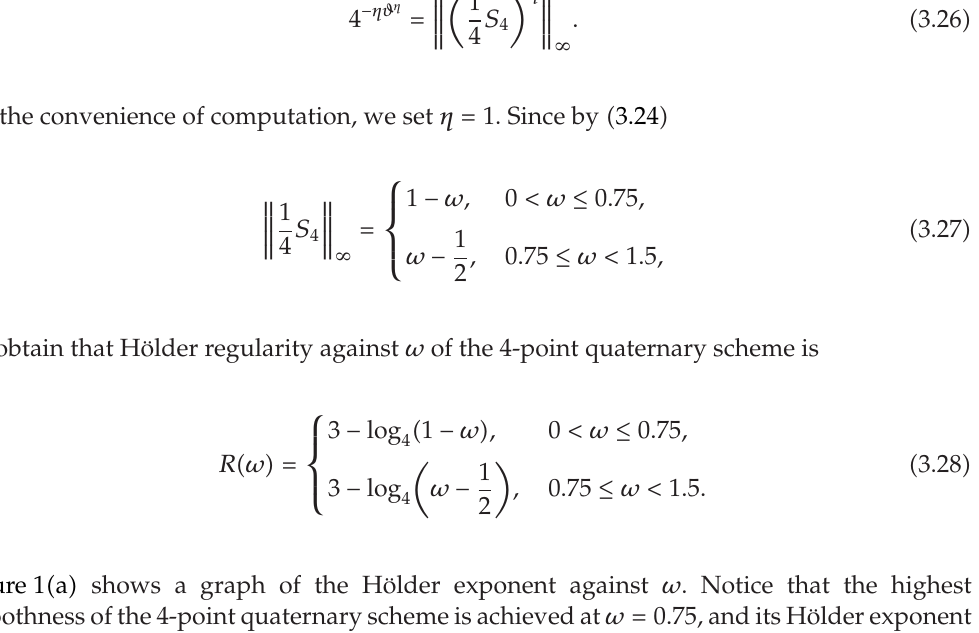
Figure 1 (cid:2) a (cid:3) shows a graph of the H ¨ older exponent against ω . Notice that the highest smoothness of the 4-point quaternary scheme is achieved at ω (cid:8) 0 . 75, and its H¨older exponent is R H (cid:8) R (cid:2) 0 . 75 (cid:3) (cid:8) 4 . Figure 1 (cid:2) b (cid:3) shows the result of proposed scheme (cid:2) 1.1 (cid:3) after four subdivision levels. In this figure the control polygon is drawn by dotted lines. The thin solid line is produced by setting ω (cid:8) 0 . 75, and the bold solid line is produced by setting ω (cid:8) 0 .